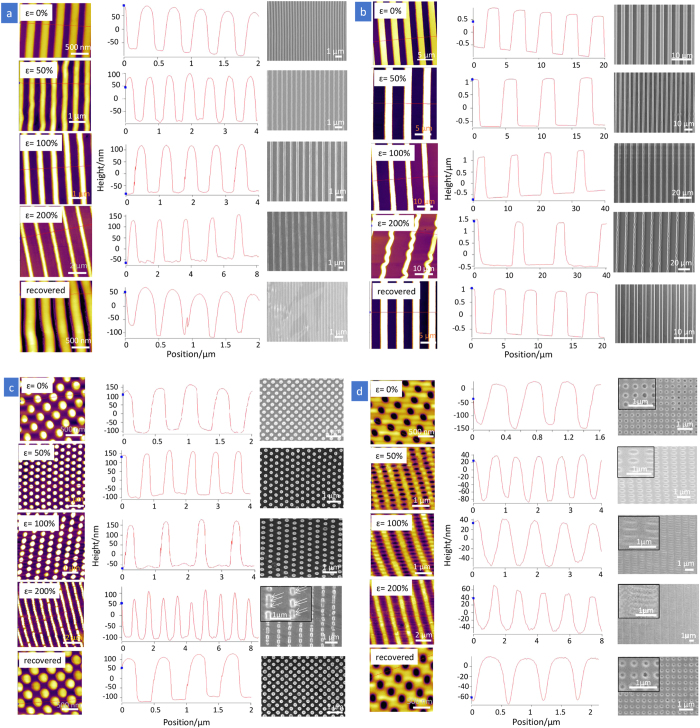
Morphological analyses of original pattern, deformed pattern under different tensile strains and recovered pattern.(a) 200 nm-grating, (b) 2 μm-grating, (c) 250 nm-pillars and (d) 200 nm-holes. Left: topographic AFM images; Centre: corresponding height profiles from AFM images; Right: top-view SEM images. Note that the scales for x- and y-axes in the height profiles of AFM are different so as to clearly present the values of dimensions on surface topographies.